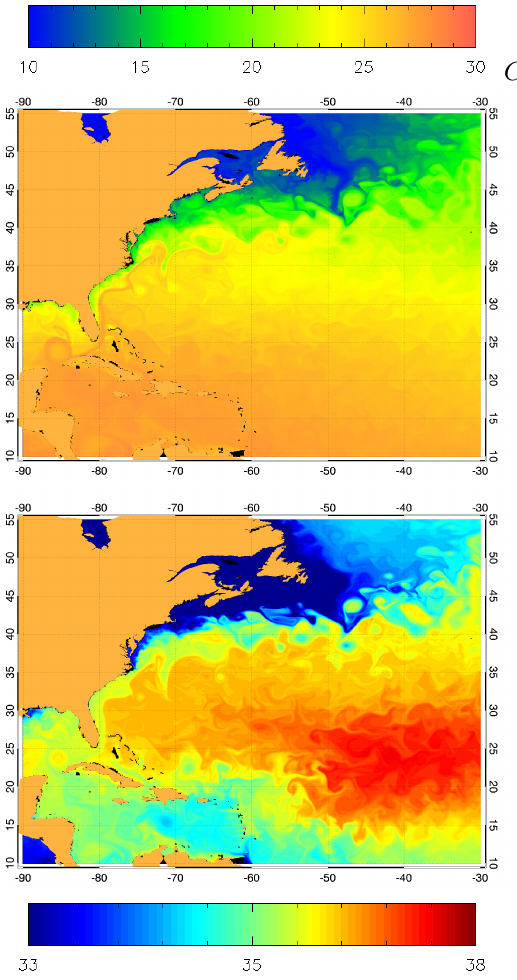
Fig. 2. OFES outputs for 1 January 1990 in the Gulf Stream area. Top: SST, bottom: SSS.